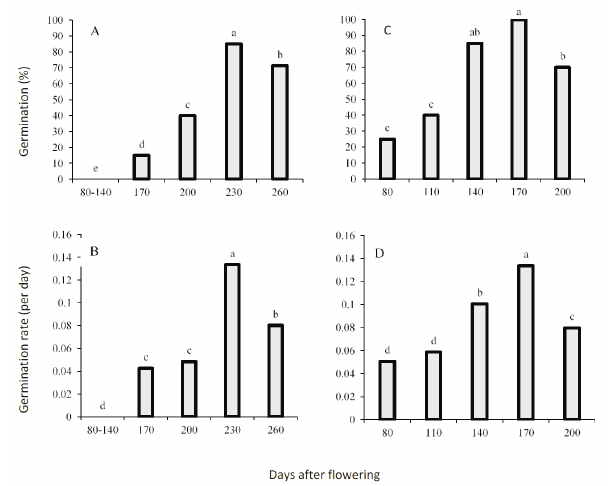
Fig. 3 ­ Effect of harvest time on germination percentage and germination rate of sour orange (A, B and Mexican lime (C D), under in vitro conditions. Means with the same let­ ter are not significantly different at 1% probability using LSD test.